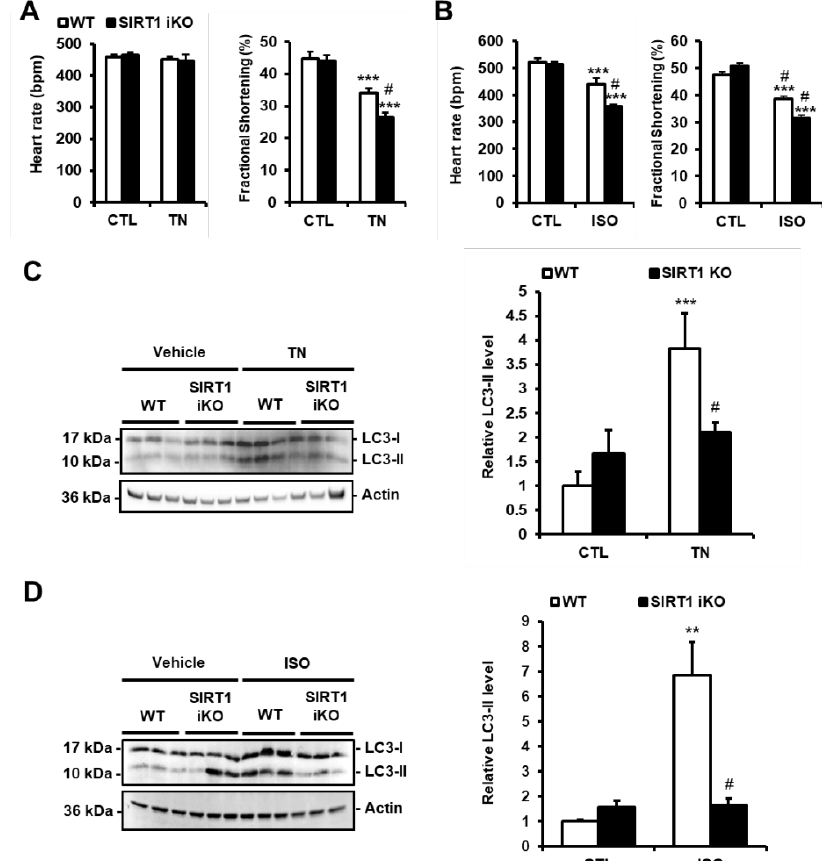
Figure 4. SIRT1 deficiency exacerbates cardiac dysfunction and decreases autophagy induced by ER stress. ( A , B ) WT and SIRT1 iKO mice were injected i.p. with tunicamycin (TN, 2 mg / kg) or vehicle (PBS) ( A ) or subcutaneously with Isoproterenol (ISO, 150 mg / kg) or vehicle (NaCl 0,9%) for 48 h ( B ) and heart rate and fractional shortening were recorded. Results are presented as mean ± S.E.M. (n = 12 for TN and n = 5 for ISO). ( C , D ) The levels of LC3-II were analyzed by Western blot in WT or SIRT1 iKO mice after TN ( C ) or ISO ( D ) treatment. Actin was used as a loading control. Relative expression of proteins is presented in bar graphs as mean ± S.E.M (n = 5–8). ** P < 0.01, *** P < 0.005 versus respective control. # P < 0.05, ## P < 0.01 versus WT TN or WT ISO.